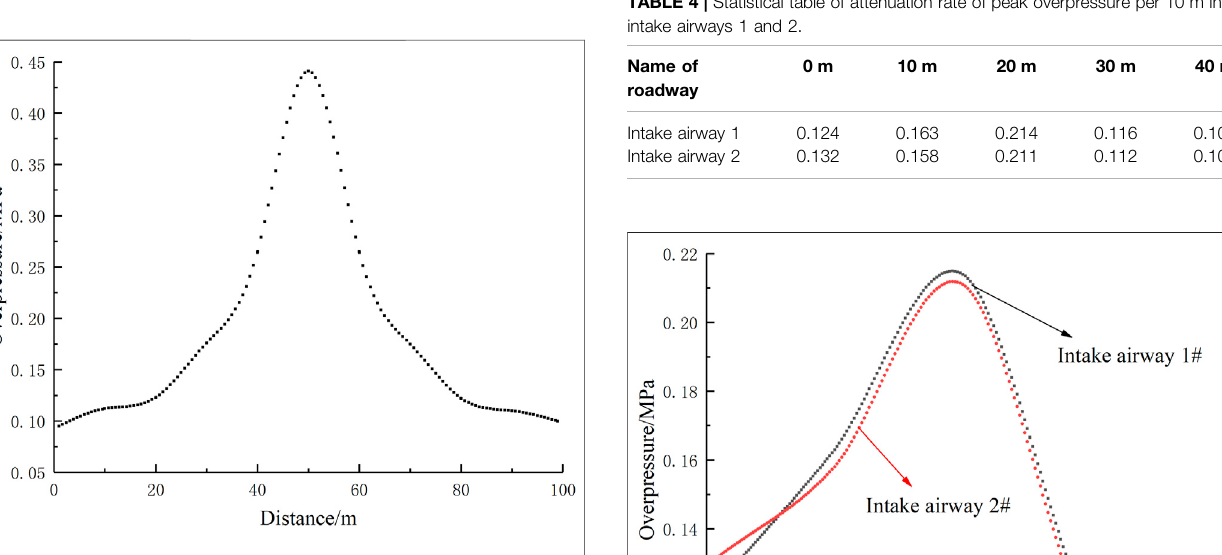
FIGURE 13 | Variation of overpressure peak in working face with distance.